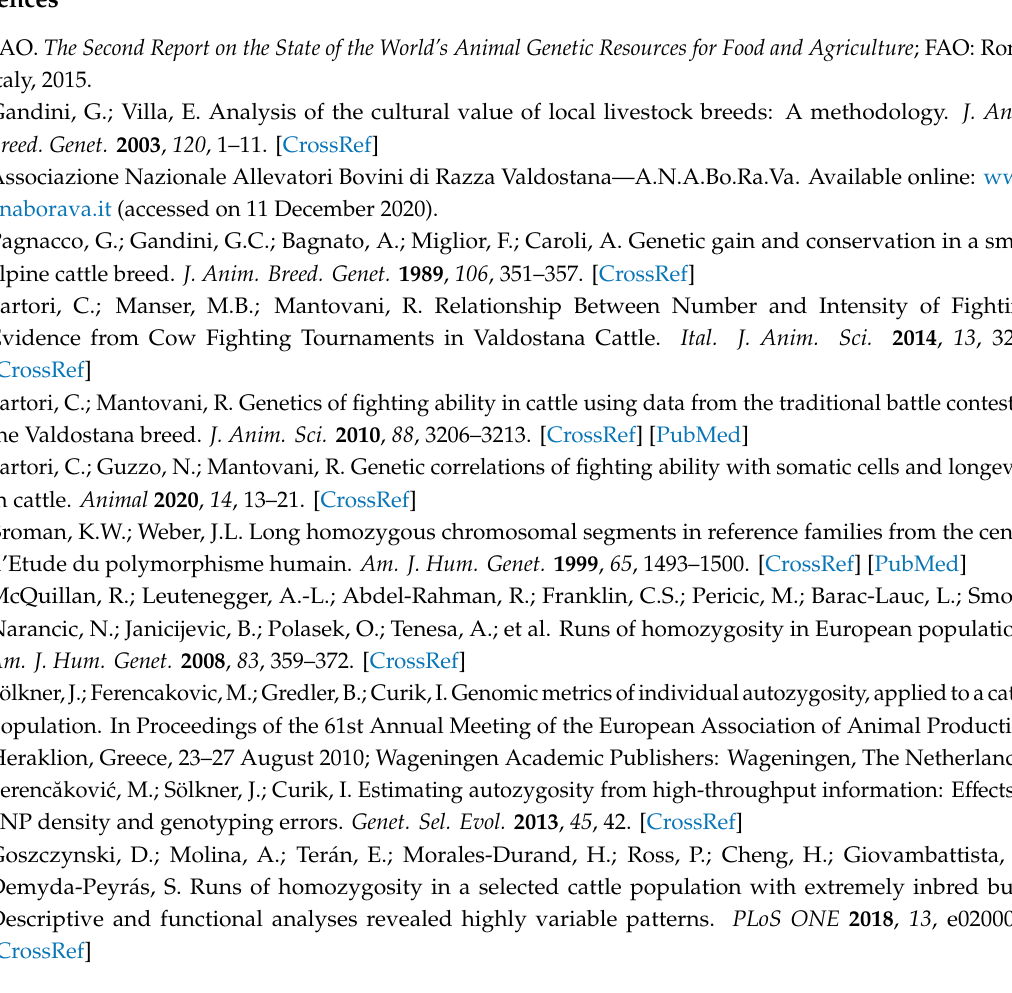
Figure S1: Manhattan plot of marker-based F ST values obtained in each breed comparison, Figure S2: Frequencies of ROH per chromosomes and chromosomes mean length (Mb) calculated for the three breeds, Figure S3: Annotation of SNPs defining the three breed TOP_ROH, Figure S4: F ROH along all chromosomes of the three breeds, Table S1: F ST by marker values for CAS vs. VRP (sheet1) and for VBP vs. VRP (sheet 2) comparisons, Table S2: Annotation of genes mapped in CAS TOP_ROH (sheet 1), in VBP TOP_ROH (sheet 2), and VRP TOP_ROH (sheet 3)